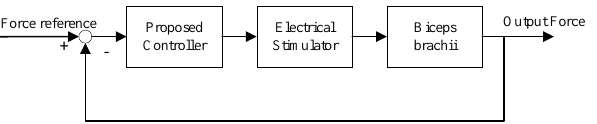
Figure 2. Closed–loop control system of biceps force tracking control.